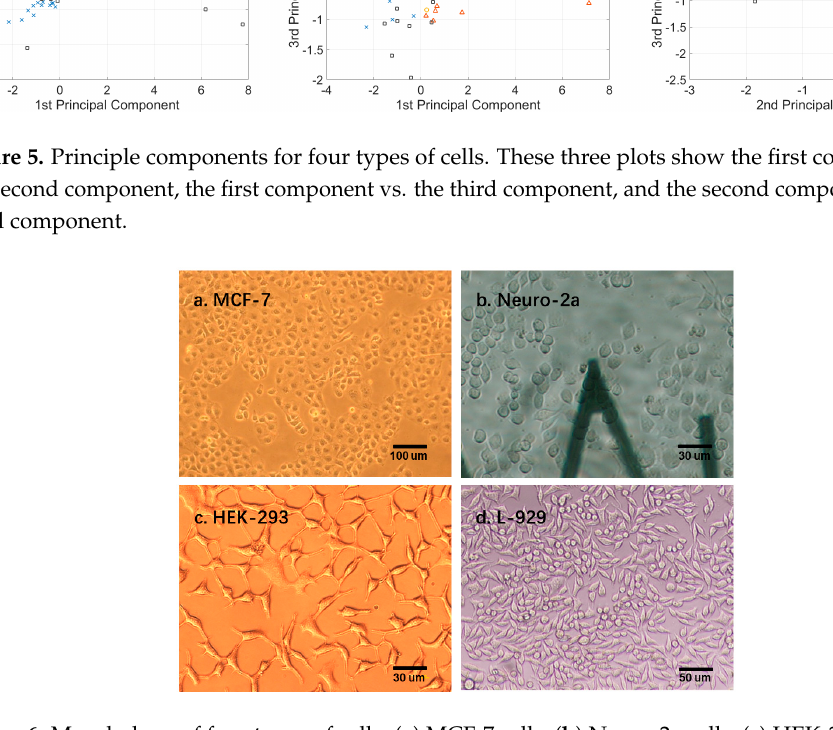
Figure 6. Morphology of four types of cells. ( a ) MCF-7 cells, ( b ) Neuro-2a cells, ( c ) HEK-293 cells and ( d ) L-929 cells. MCF-7 and Neuro-2a cells each showed less variance in morphology than HEK-293 and L-929 cells. The magnification is 10, 40, 40, and 20, respectively.